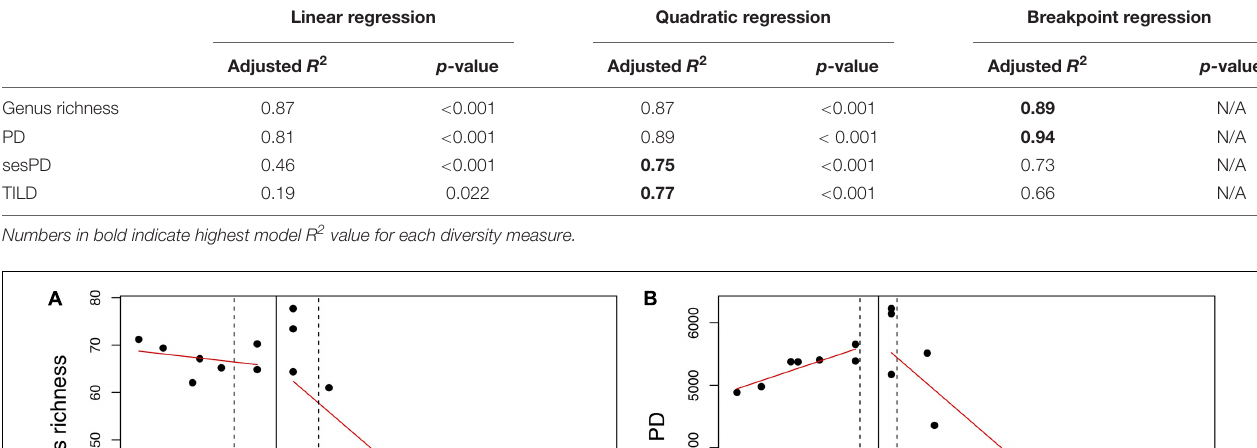
up to an estimated breakpoint at 1,410 m asl ( ± 129m), and